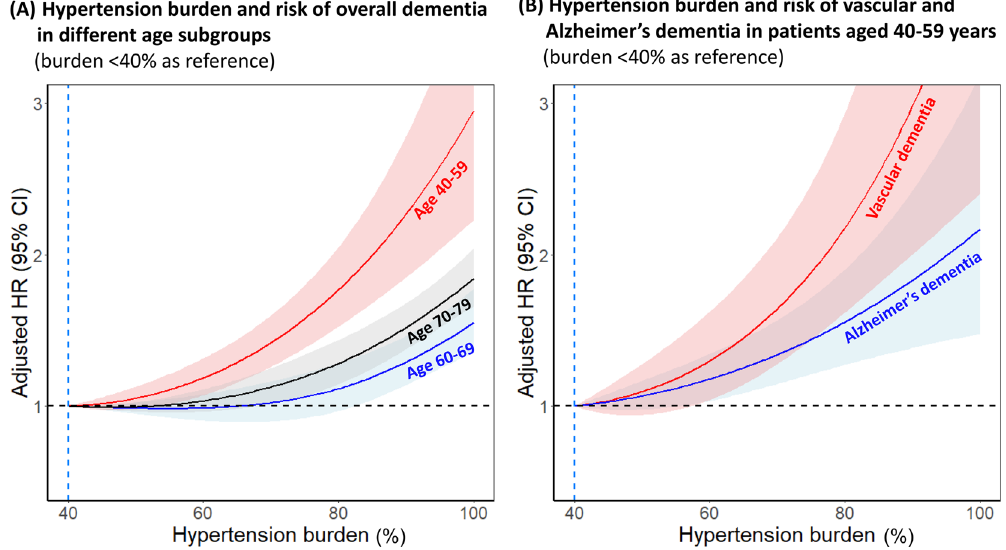
Figure 5. ( A ) Hypertension burden and risk of overall dementia measured in different age subgroups (burden < 40% as reference) ( B ) Hypertension burden and risk of vascular and Alzheimer’s dementia in patients aged 40–59 years (burden < 40% as reference). Spline curves represent HRs adjusted same as Fig. 3. CI confidence interval, HR hazard